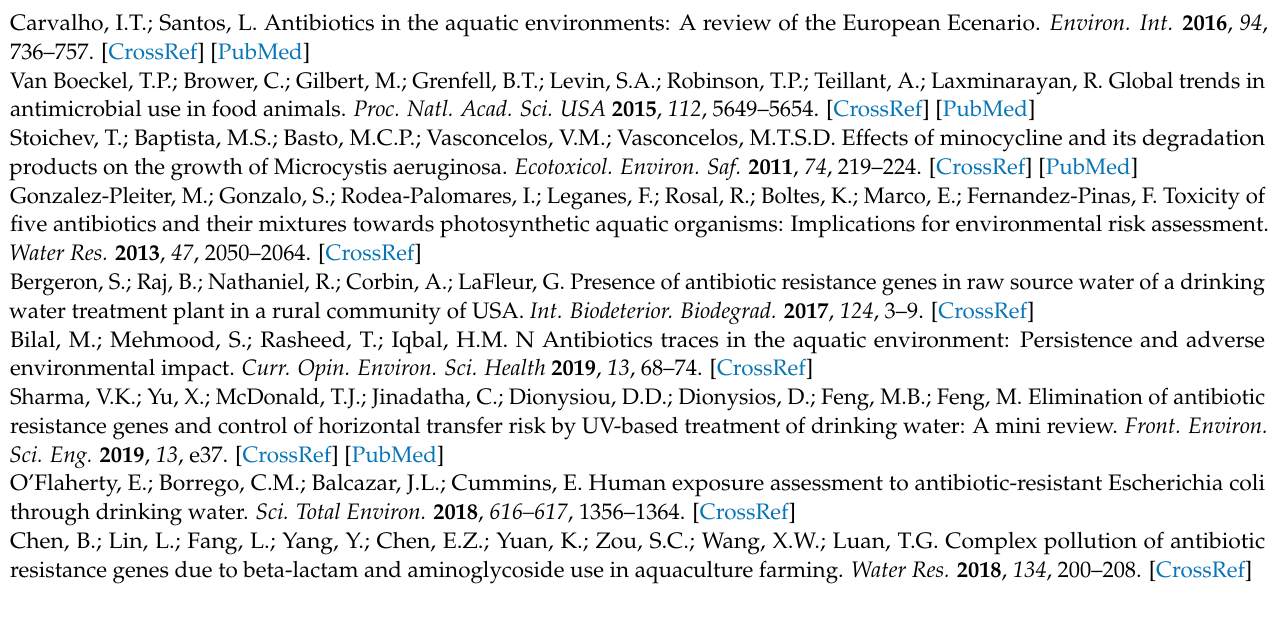
Figure S4. (a) The response time of the interaction between GMPA@CdTe QDs and CIP; (b) The stability of the fluorescence ratio (F 440 /F 710 ) of GMPA@CdTe QDs in PBS; Figure S5. (a) Fluorescence spectra of the GMPA@CdTe QDs in the presence of various concentrations of CIP (0–10 mM); (b)